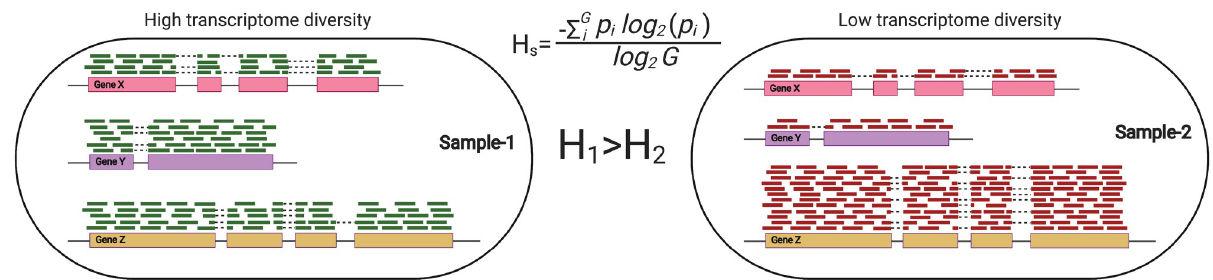
Fig 1. Illustration of transcriptome diversity. Transcriptome diversity ( H s ) was computed per sample based on Shannon entropy. G is the total number of expressed genes and p is the probability of observing a transcript for gene i . An example of two samples with three genes is shown, where i one sample has a higher transcriptome diversity value ( H 1 ) with more evenly distributed sequencing reads aligned to genes than the other sample ( H 2 ) with one gene responsible for the majority of the sequencing